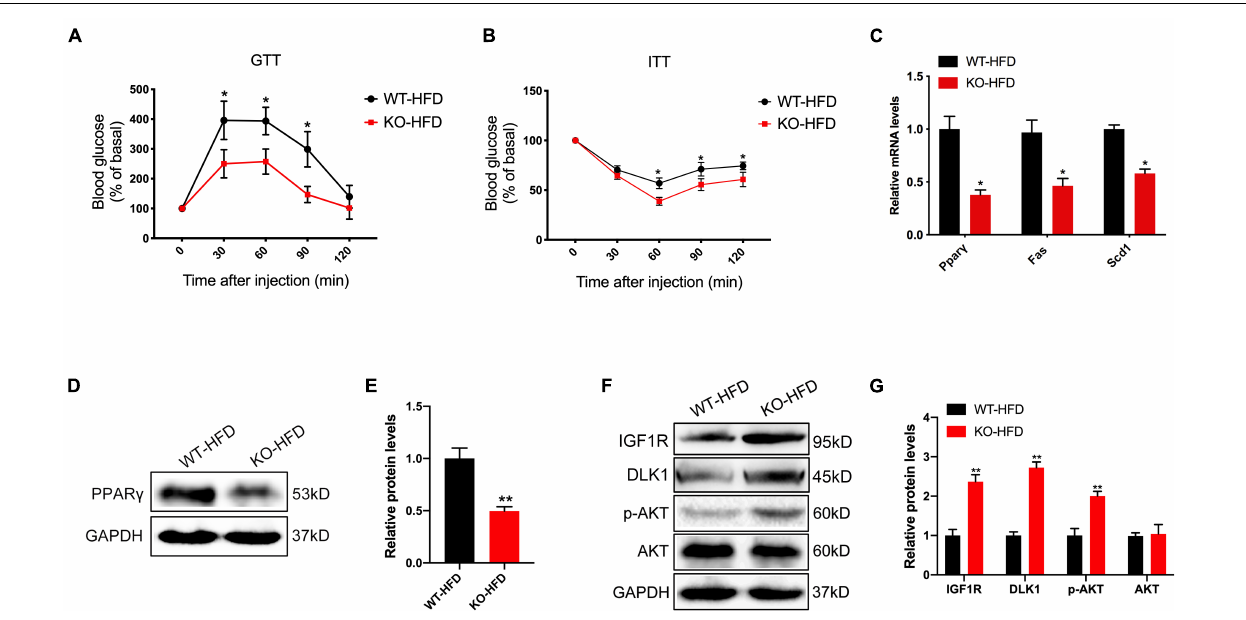
FIGURE 4 | The miR-379/miR-544 cluster KO mice exhibit reduced obesity-associated insulin resistance after feeding with 10 weeks of HFD. (A,B) Blood glucose levels in WT-HFD and KO-HFD mice ( n = 4) during a glucose-tolerance test (GTT) (A) and insulin-tolerance test (ITT) (B) . * P < 0.05. (C) RT-qPCR analyses of lipogenic genes ( Ppar γ , Fas, and Scd1 ) expression in livers from WT-HFD and KO-HFD mice ( n = 3). * P < 0.05. (D,E) The protein level of PPAR γ in livers from WT-HFD and KO-HFD mice ( n = 3) was determined (D) and quantified (E) by Western blot analysis. ** P < 0.01. (F,G) Western blot analysis (F) and quantitation (G) of IGF1R, DLK1, phosphorylated AKT (p-AKT), and total AKT in the livers from WT-HFD and KO-HFD mice ( n = 3). ** P <